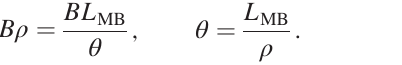
FIG. 3. Schematic layout of quadrupoles (Q) and main dipoles (MBs) of the lattice from the IP to Q14, for an experimental IR, where the latter spans from the IP to the start of Q7. Q1 to Q3 form the inner triplet (IT). The interaction region (IR) proper extends through Q7. After the matching section (Q4 to Q6), the irregular part of the dispersion suppressor (DS) spans from Q7 to Q11. Following a drift space the regular DS includes Q11 to Q13, and the regular arc lattice structure starts at Q11.